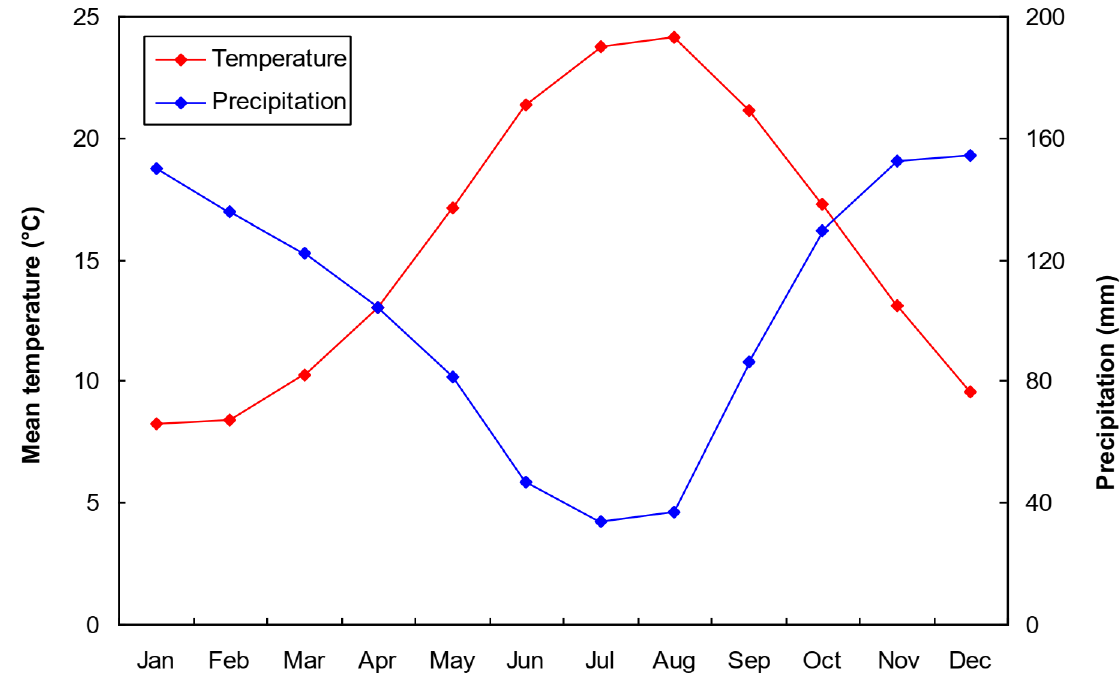
Figure 2. Walter and Lieth diagram for the meteorological station of Cittanova (Southern Italy, data of the period